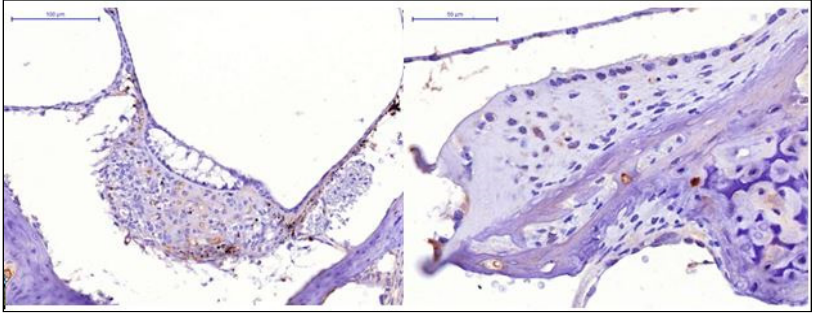
Figure 1. Absence of HIF-1 expression in the cells of the receptor apparatus, low HIF-1 expression in the cells of the spiral ganglion ( left ): control group, ( right ): Cytoflavin. When the therapeutic dose of 5 mg/kg was administered, we observed low HIF-1 expression in the cells of the receptor apparatus and moderate HIF-1 expression in the cells of the spiral ganglion. When the therapeutic dose of 7 mg/kg was administered, we observed moderate HIF-1 expression in the cells of the receptor apparatus and the cells of the spiral ganglion. The pronounced HIF-1 expression was observed after administering the therapeutic dose of 10 mg/kg injected 2 h after the acoustic trauma (Figure 2).